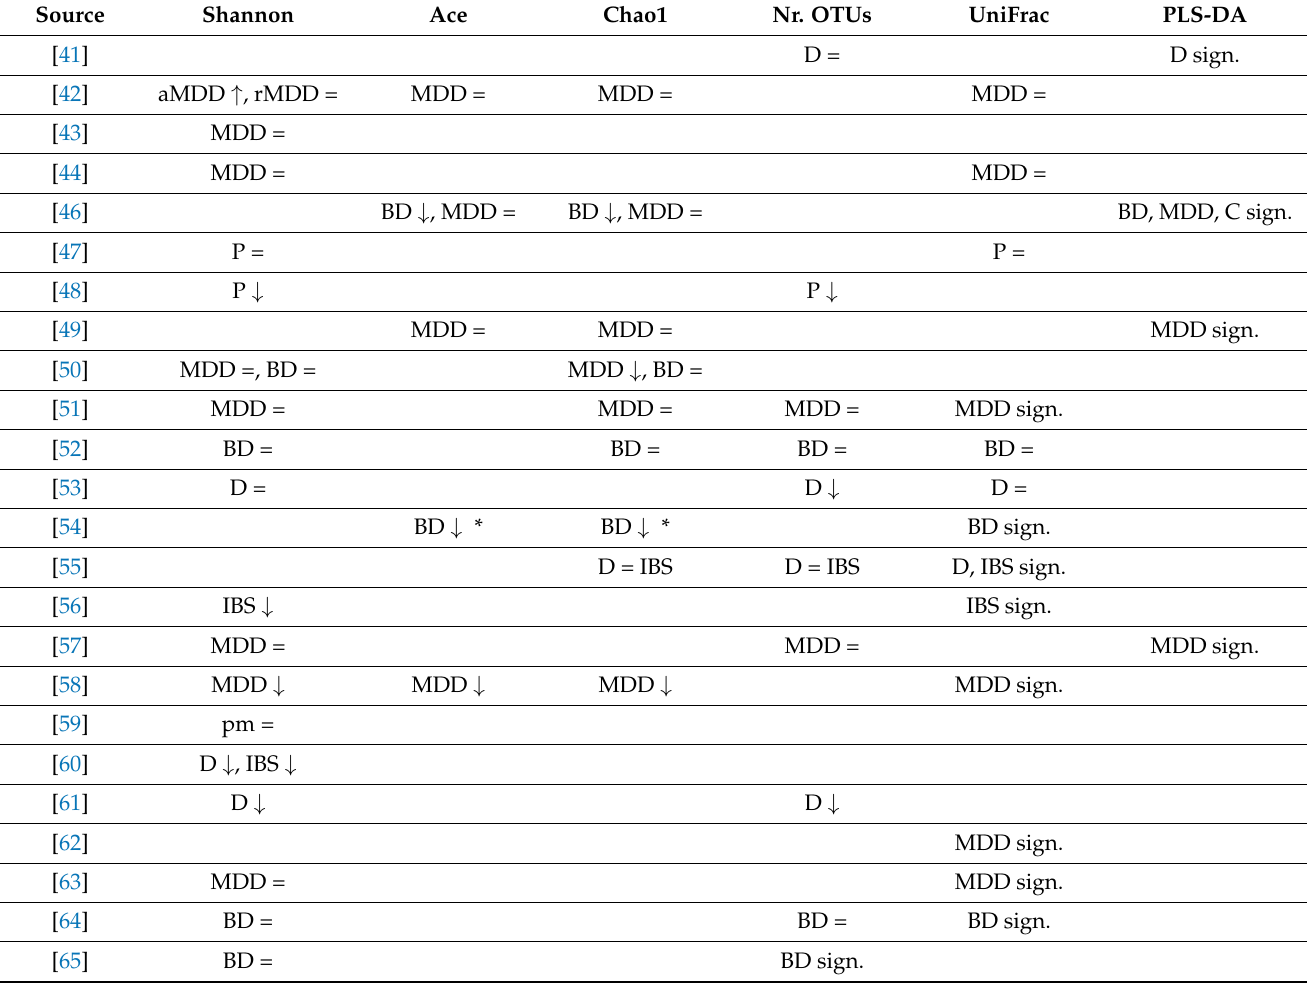
Table 1. A selection of the most used diversity indices and measures, showing an unchanged or lower microbial diversity in depressed